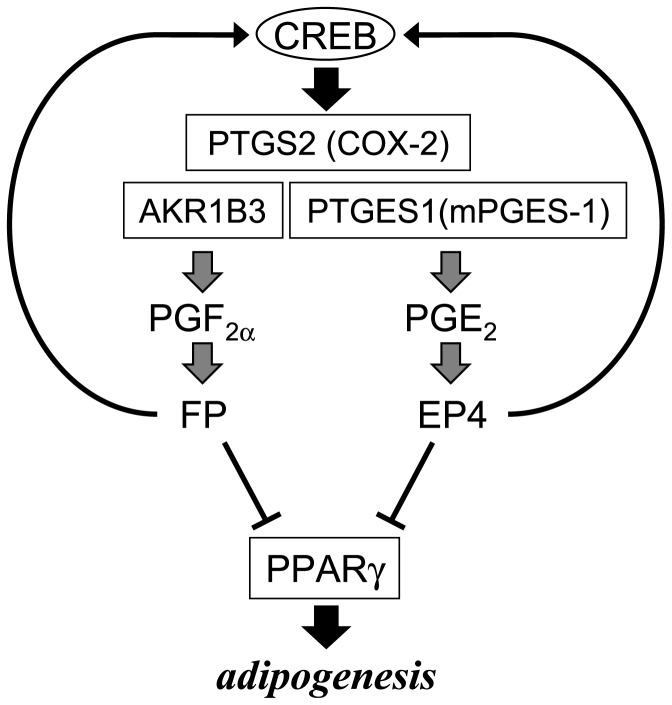
Synergistic suppression of the early phase of adipogenesis by PGE2 and PGF2α in 3T3-L1 cells.